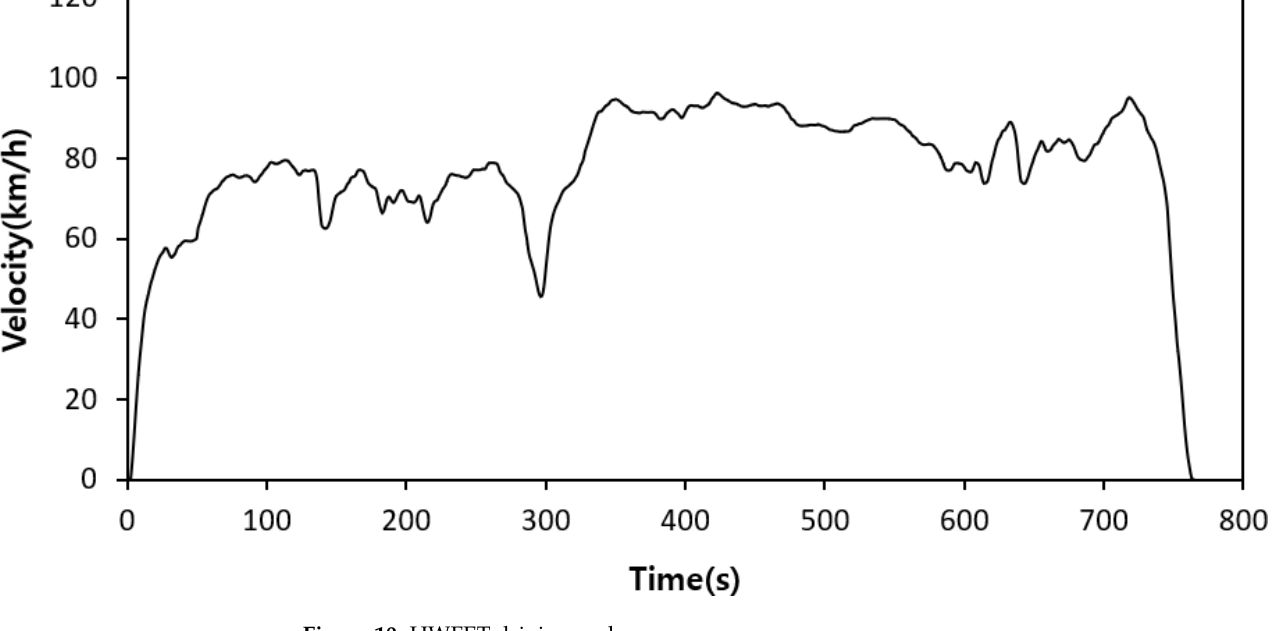
Figure 10. HWFET driving cycle.